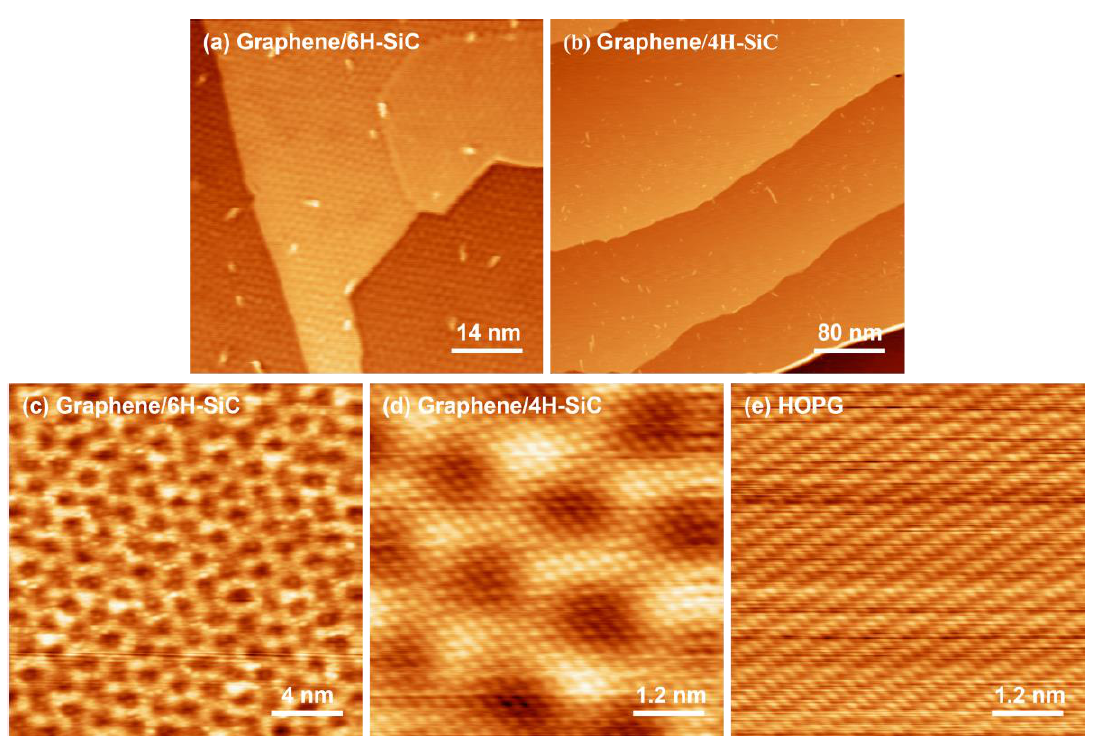
Figure 3. STM images. ( a , b ) Large-scale scan of graphene with different thickness grown on SiC substrate. ( a ) STM image of single-layer graphene on 6H-SiC (V s = −0 .9 V, I t = 200 pA). ( b ) STM image of few-layer graphene on 4H-SiC, with the fabrication method introduced in the study (V s = −1 .5 V, I t = 10 pA). ( c – e ) Atomic resolution images of graphene with different layers. ( c ) Zoom-in STM image of ( a ), single-layer graphene/6H-SiC (V s = −1 .3 V, I t = 500 pA). ( d ) Zoom-in STM image of ( b ), few- layer graphene on 4H-SiC (V s = −8 0 mV, I t = 5 nA). ( e ) Zoom-in STM image of HOPG (V s = 170 mV, I t = 1.5 nA).